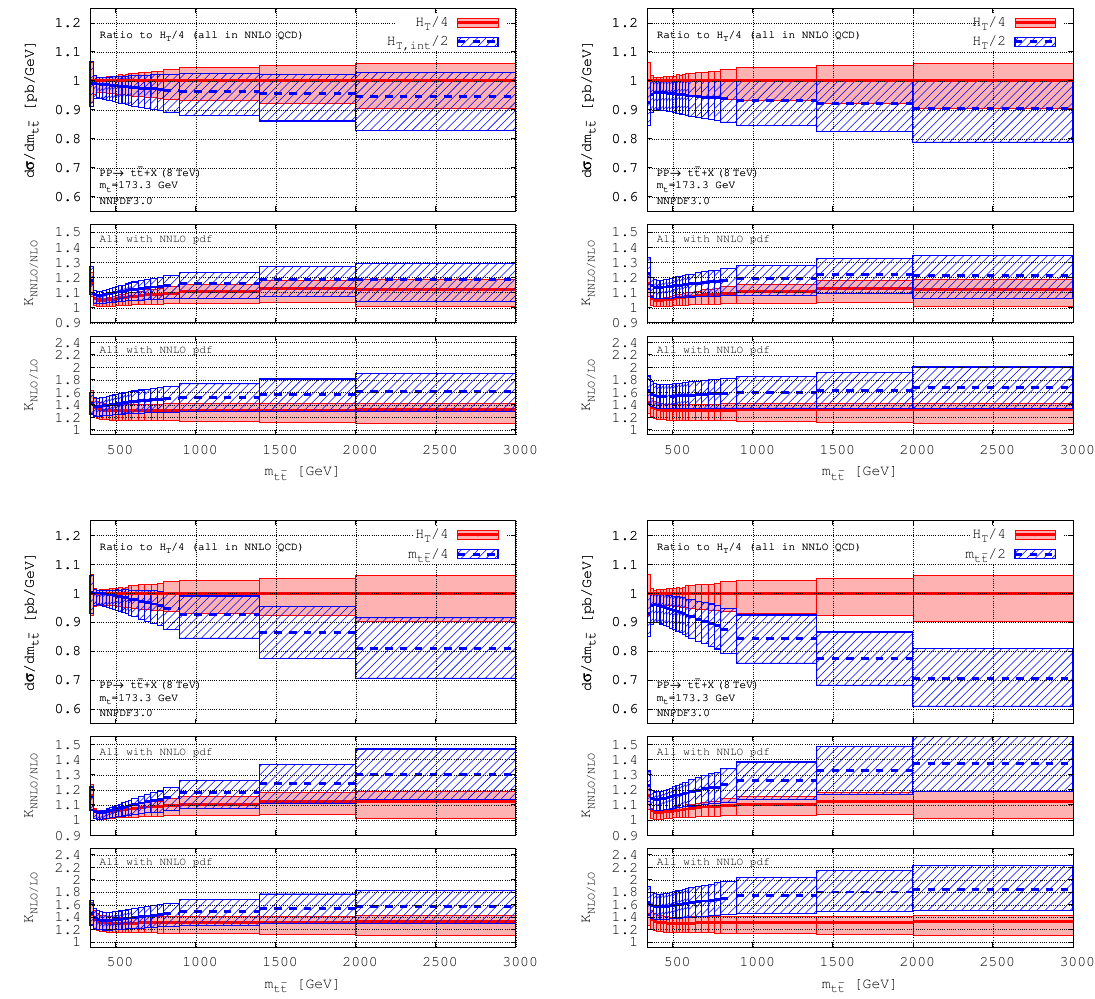
Figure 13 . As in (cid:12)gure 6, but all partonic cross-sections (LO, NLO and NNLO) are computed with NNLO